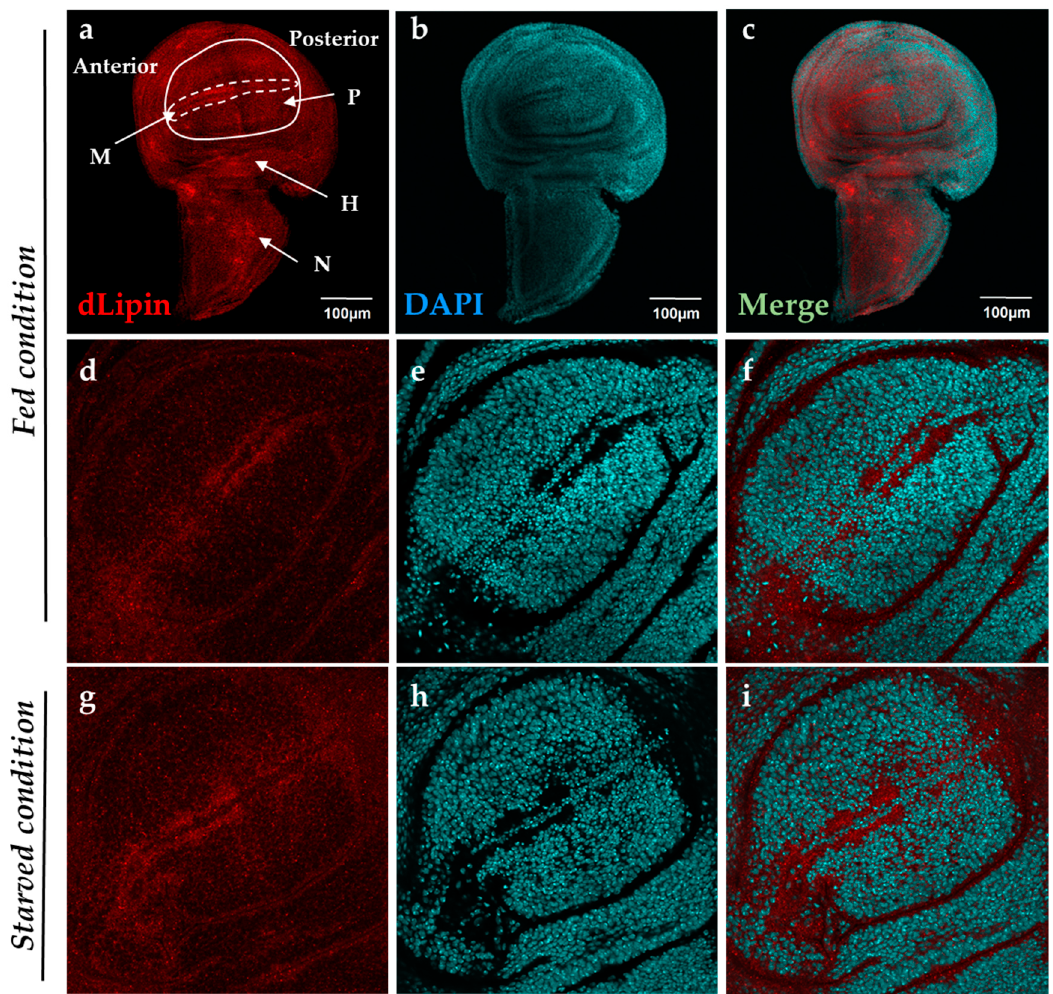
Figure 1. Localization of Drosophila lipin (dLipin) protein on the wing imaginal disc of the yw strain. Wing imaginal discs of 3rd-instar larvae were stained with 4’,6-diamidino-2-phenylindole (DAPI) ( b, e, h ) to visualize DNA, and rabbit anti-dLipin antibody ( a, d, g ) followed by anti-rabbit IgG Alexa Fluor TM 594 antibody. Merged images of DAPI and antibody staining ( c, f, i ). Fed condition ( a – f ), starved condition ( g – i ). The images are representative among images of 10–20 wing imaginal discs. dLipin protein was expressed in whole wing imaginal disc, with particularly high expression in the anterior part of the margin (M), and notum (N), albeit slightly lower expression in the wing pouch (P) and hinge (H) ( a – c ). The dotted circle indicates the margin of the wing imaginal disc. The wing pouch demarcated with the white line is shown in ( d , g ). dLipin was not detected in the nuclei of wing imaginal discs of 3rd-instar larvae either in the fed or starved state ( d – i ). Scale bar, 50 µm.